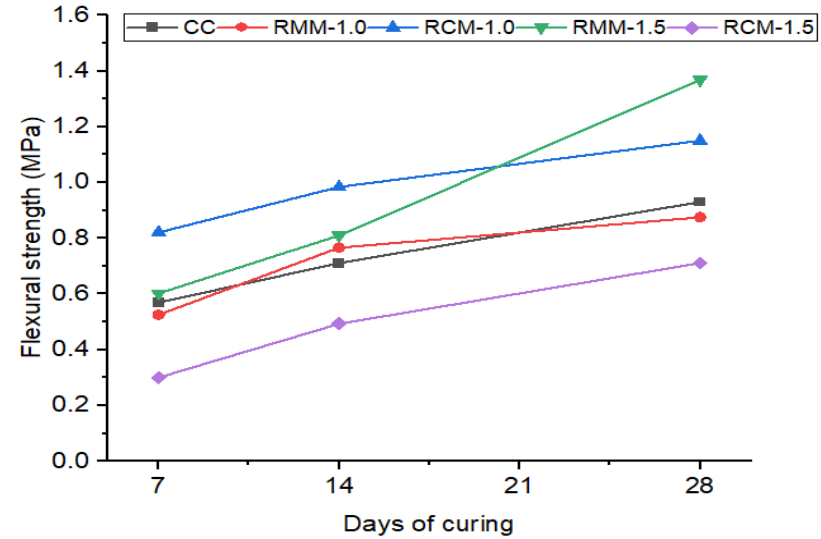
Figure 4. Flexural test results.